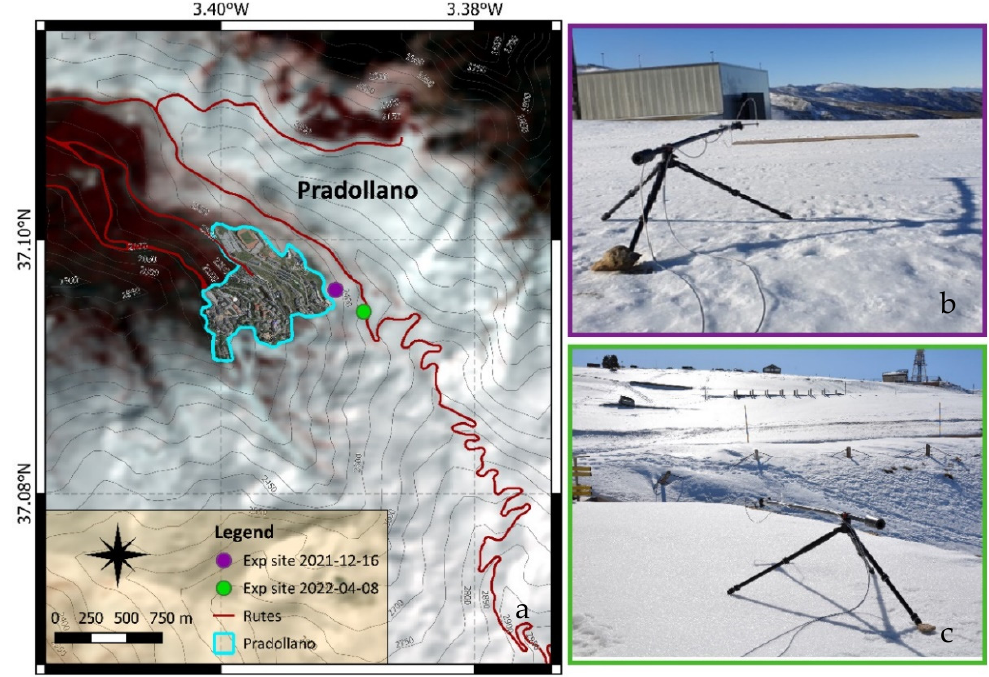
Figure 4. Location of the experimental sites ( a ) and views from the sites ( b , c ) for 16 December 2021 ( b ) and 8 April 2022 ( c ).